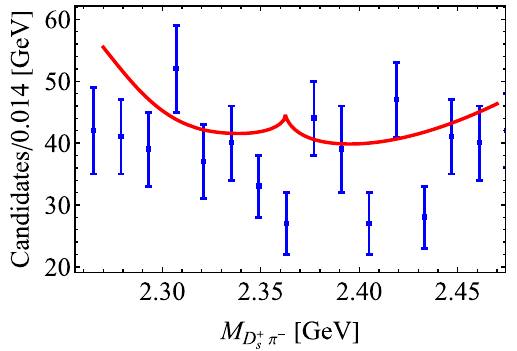
Fig. 6 Invariant mass distributions of D + s π − via the rescatterings in Fig. 1c with the interference contribution involved. The data with errors are from Ref.